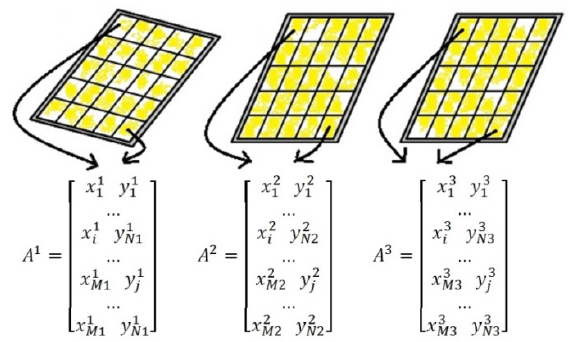
Figure 5. Constructed matrix for PCA algorithm.